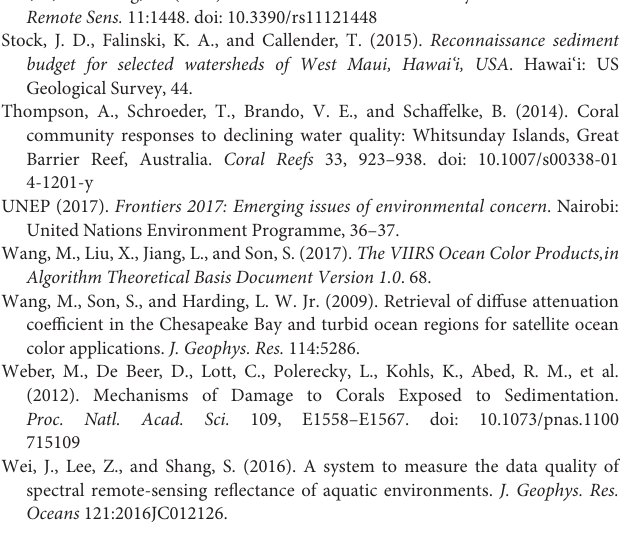
Algorithm Theoretical Basis Document Version 1.0 . 68. Wang, M., Son, S., and Harding, L. W. Jr. (2009). Retrieval of diffuse attenuation coefficient in the Chesapeake Bay and turbid ocean regions for satellite ocean color applications. J. Geophys. Res.